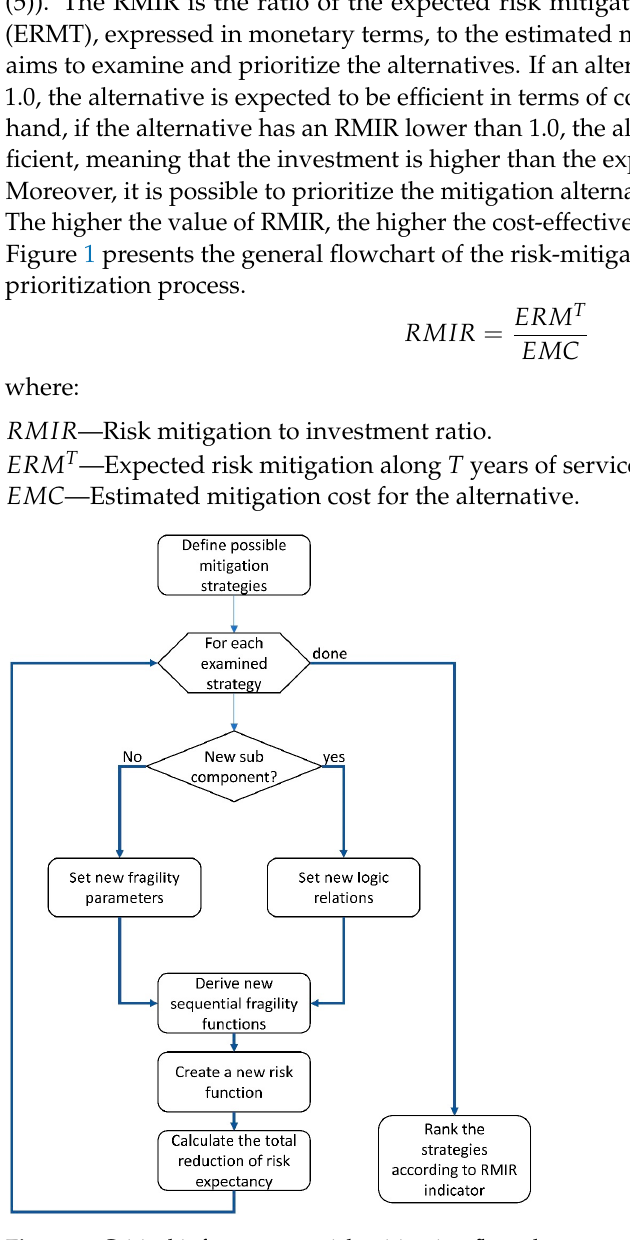
Figure 1. Critical infrastructure risk mitigation flow chart.